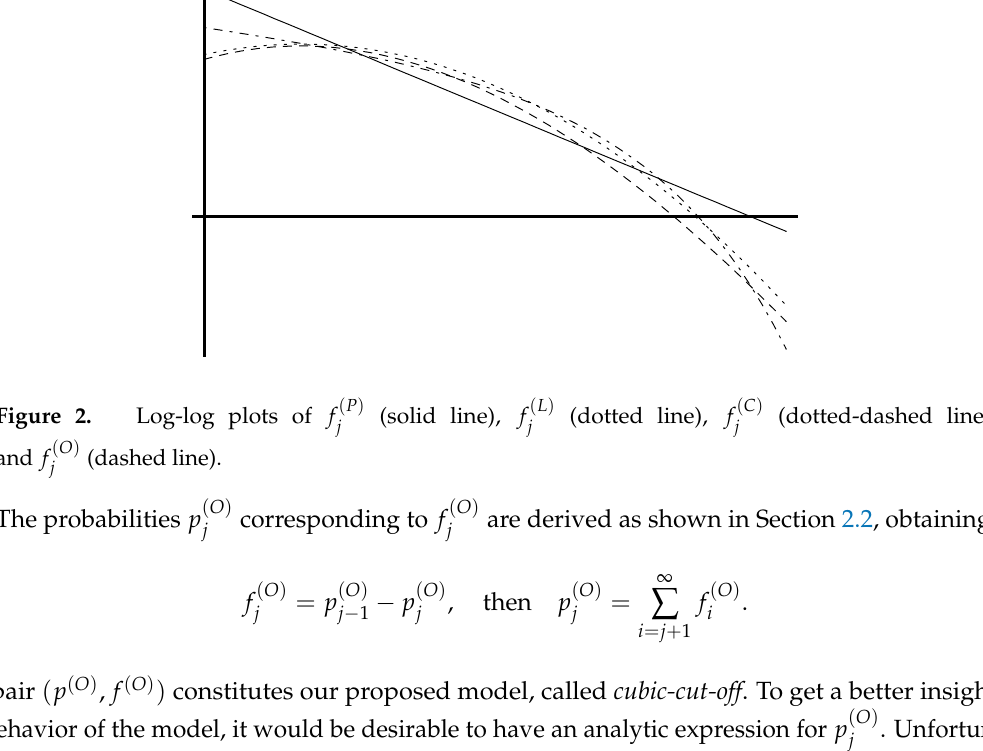
Figure 2. Log-log plots of f ( O ) and f (dashed j